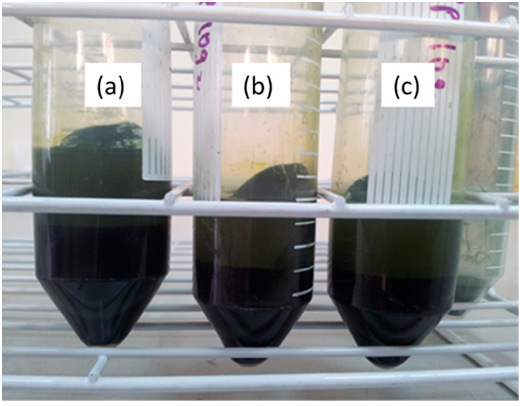
Figure 3. Extracted lipids using ( a ) Soxhlet extraction, ( b ) ultrasonication, and ( c ) solvent extraction.